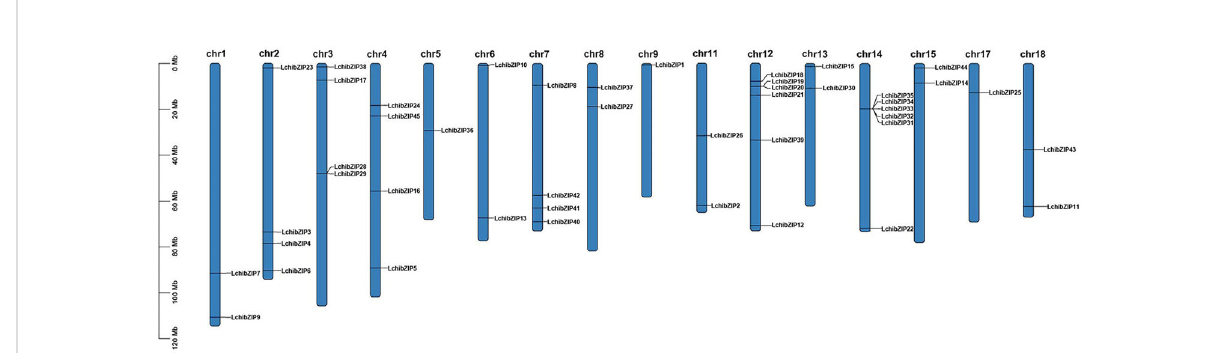
FIGURE 5 Distribution of 45 bzip genes on 16 chromosomes of L. chinense . Chromosome lengths and gene positions can be inferred from the scale on the left.